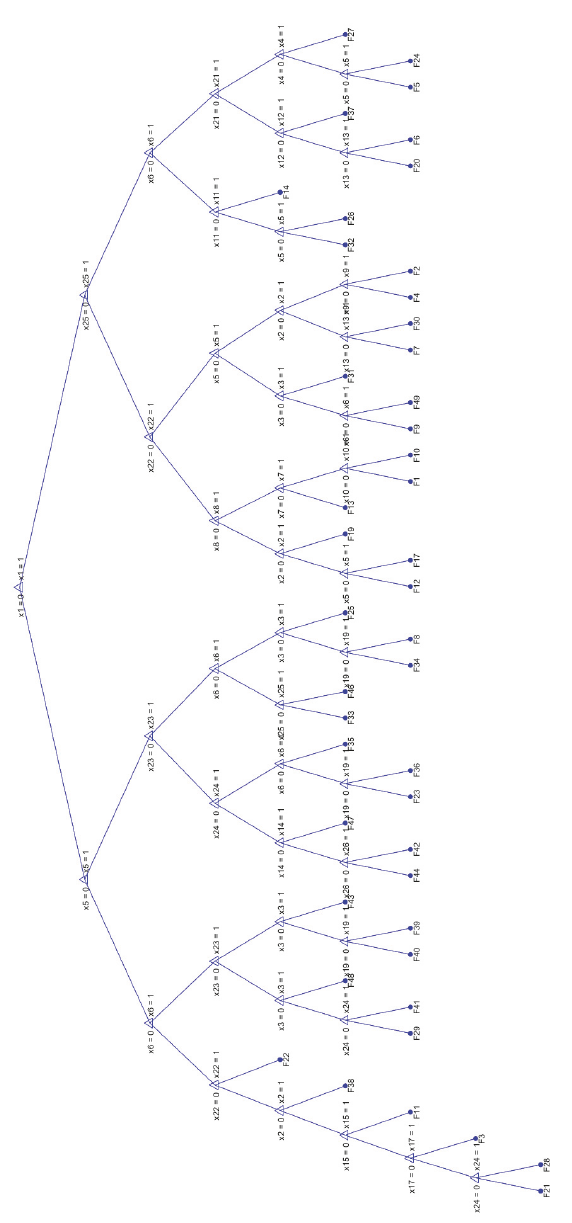
Figure 7: DT obtained with standard CART split criteria and Deviance